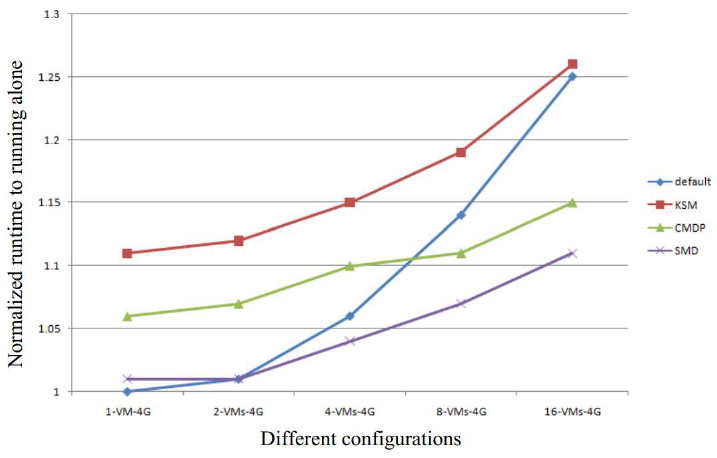
Figure 11. The average runtime of applications or